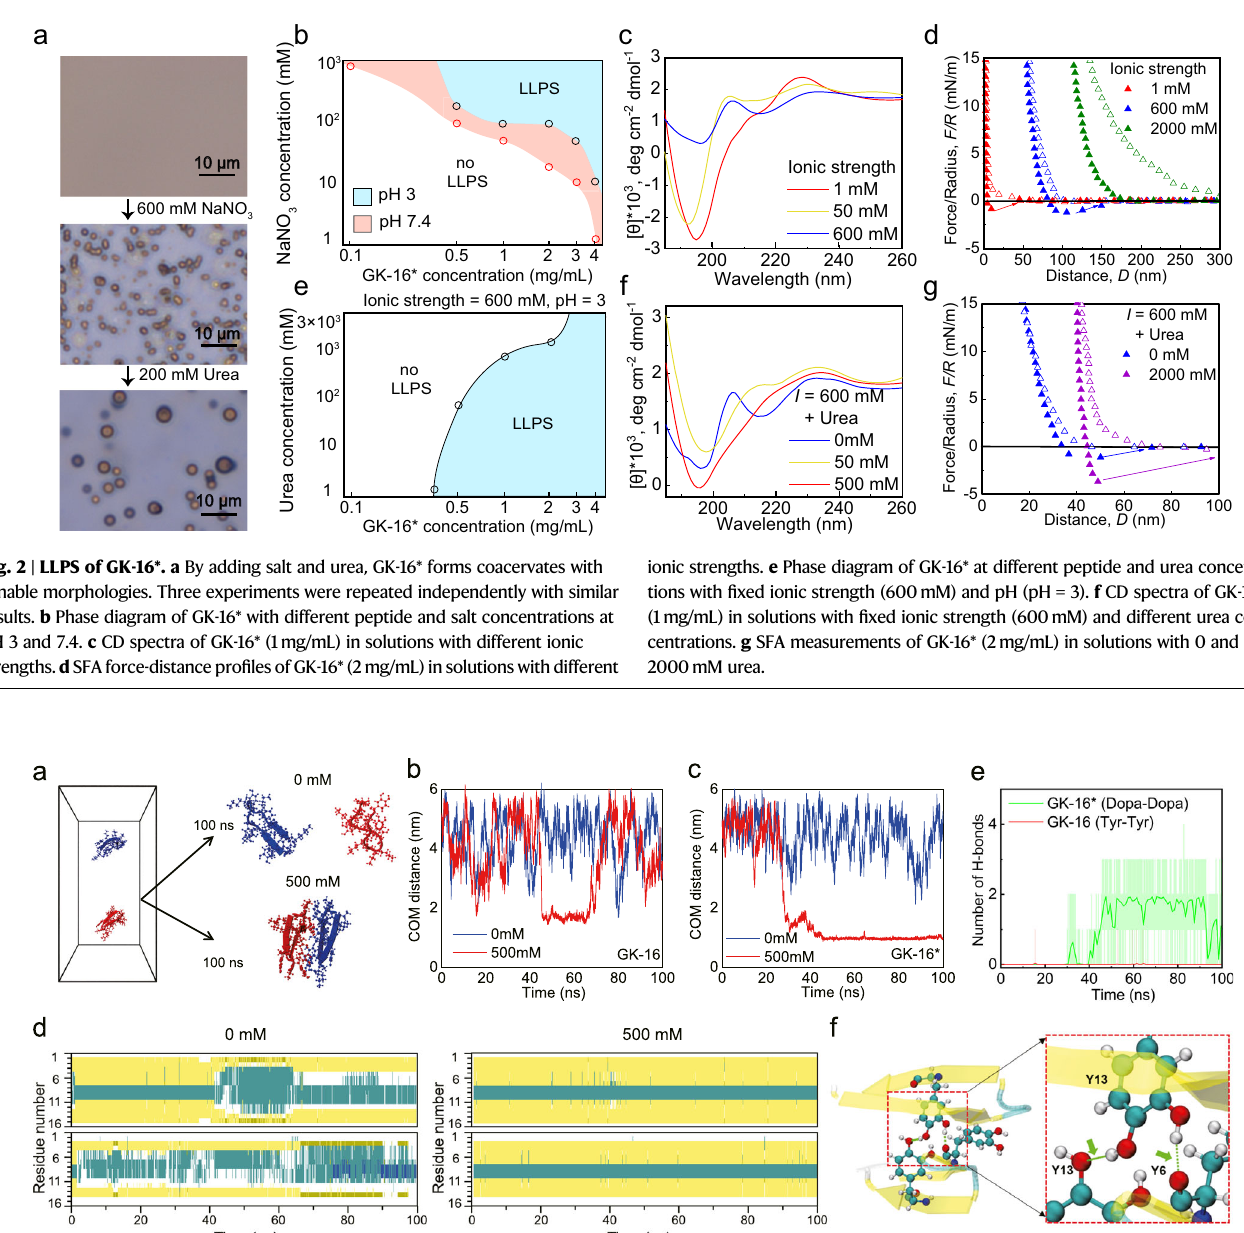
in simulations. e The temporal evolutions of the number of H-bonds formed between Dopa residues in GK-16* and Tyr residues in GK-16 (transparent line) and the corresponding average over 1ns (solid line) during the interaction process. f Representative con fi gurations of the associated GK-16*; the right panel shows a magni fi ed view of the bidentate H-bonds, green arrows indicating the H-bonds. Atoms in Dopa residues are colored as follows: hydrogen, white; oxygen, red; carbon, cyan; nitrogen,